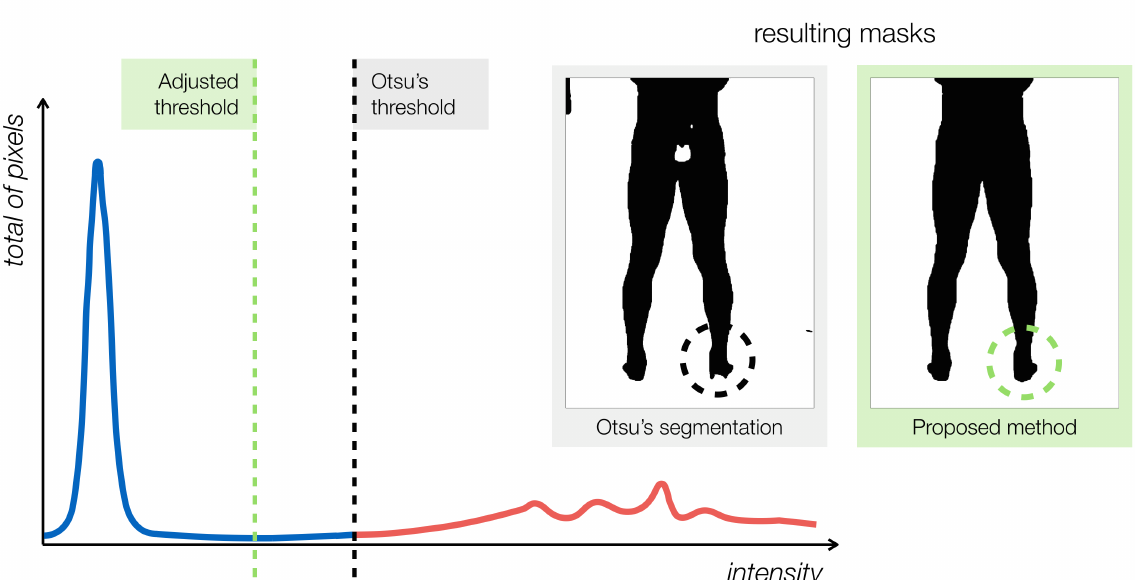
threshold is used so that more pixels are included in the ROI (body-mask). The black dashed line is Otsu’s optimal threshold. The green dashed line is our method’s adjusted threshold. Picture insets illustrate the effect of adjusting the threshold ( i.e. , the foreground region is expanded, correcting segmentation near the feet areas) and removing small